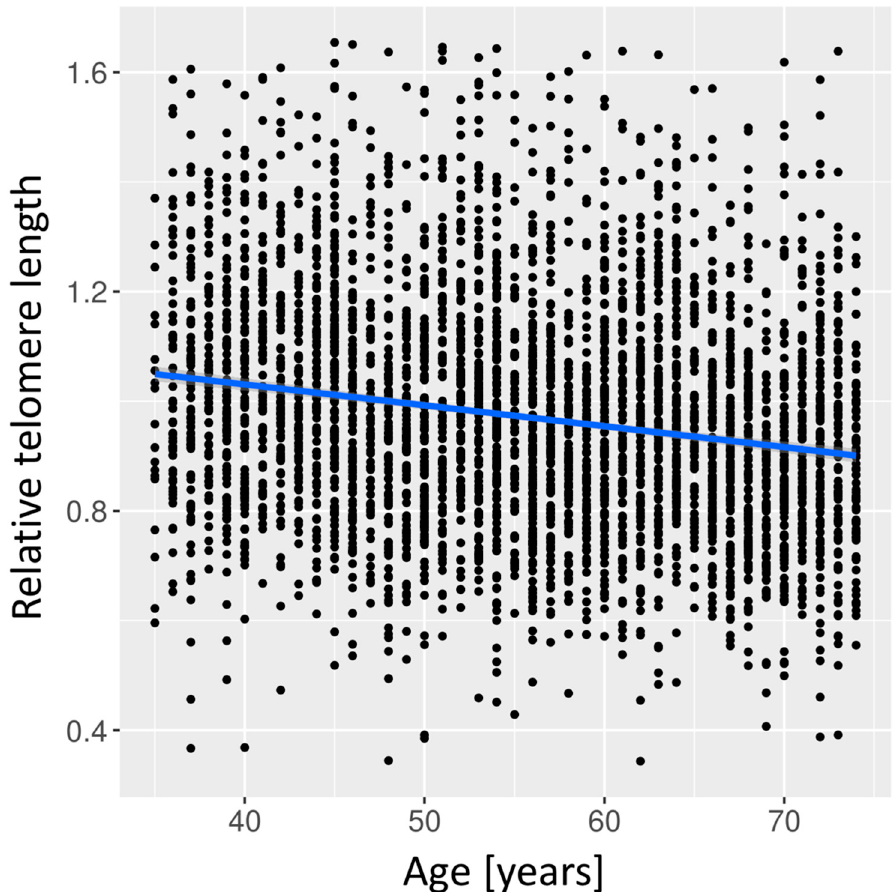
Figure 1. Correlation of relative telomere length with age. Relative telomere length was adjusted for age, batch, and PCR plate. E ff ect = − 0.004, 95% confidence interval ( − 0.005– − 0.004), p -value = 3.2 × 10 − 47 . Table 2. Multivariable linear regression analysis of relative telomere length on cardiovascular risk factors. Relative telomere length was adjusted for age, batch, and PCR plate.